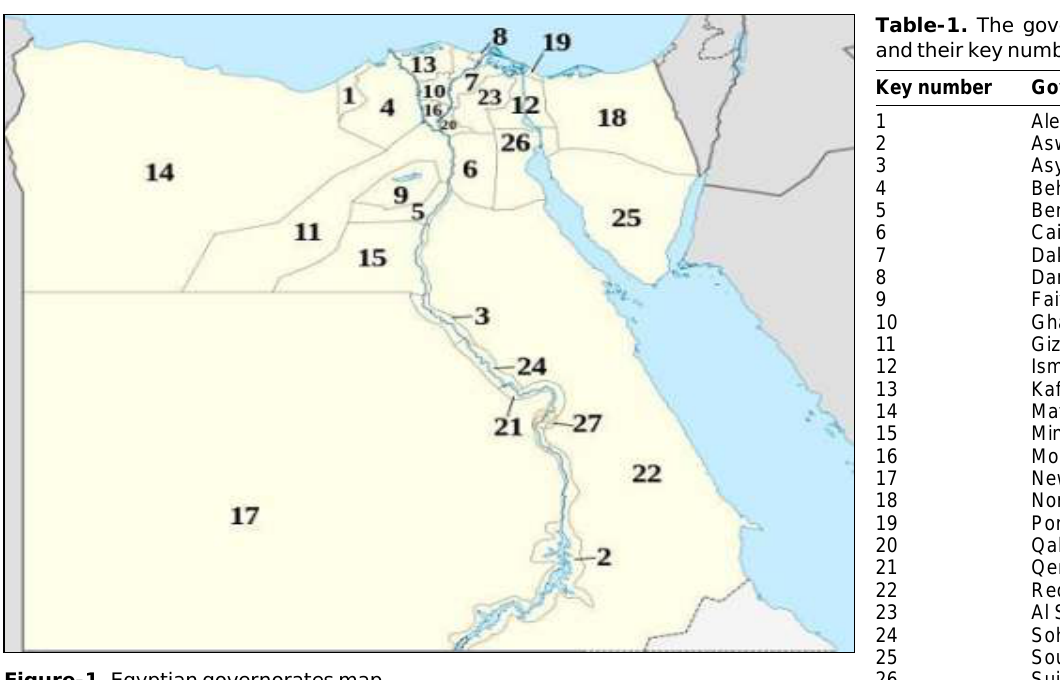
Figure-1. Egyptian governorates map. (source:http://en.wikipedia.org/wiki/ Governorate_of_Egypt) Table-2. AGPT for detection of BTV antibodies in the serum samples.